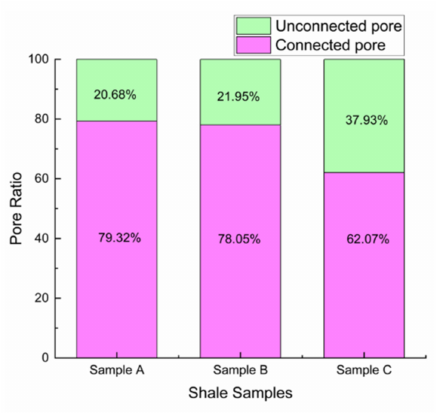
Figure 9. Pore connectivity analysis of three shale samples.